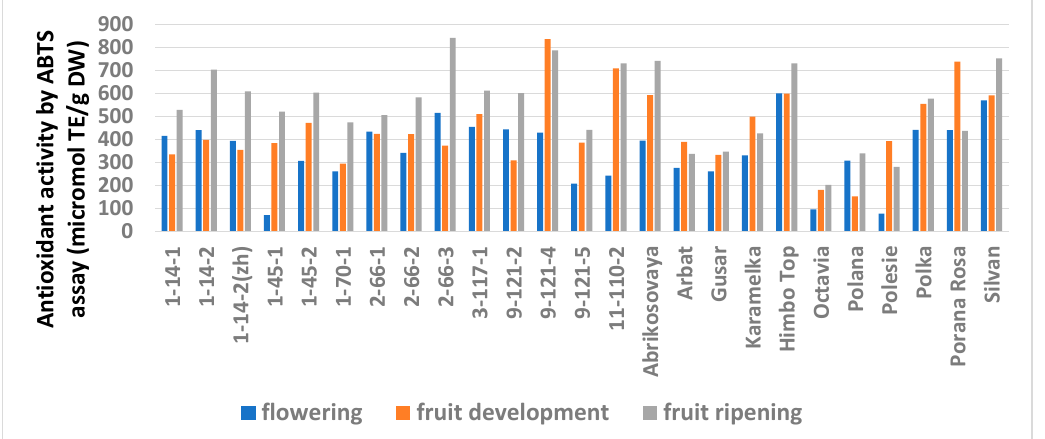
Figure 4. Effect of different harvest periods (phenophase) on antioxidant activity of raspberry leaves measured by ABTS assay. Statistical analysis of the data is presented in Table S7.